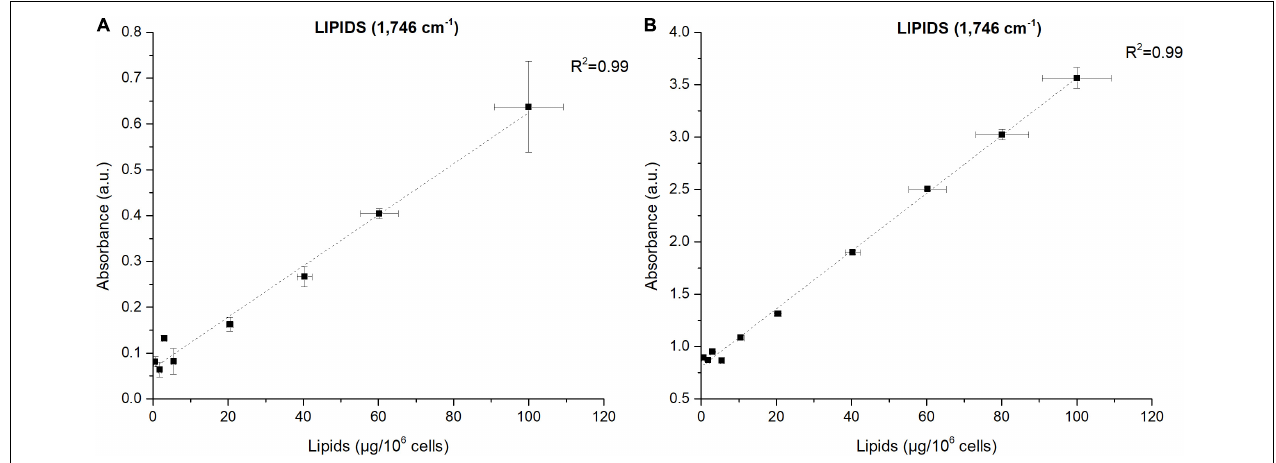
FIGURE 3 | Correlations between FTIR absorbance measured at 1,746 cm – 1 and lipids concentrations quantified by fluorescence after Nile-Red staining considering (A) baseline-corrected spectra and (B) baseline-corrected and normalized spectra. Two million cells were deposited on the silica plate. Coefficients of determination (R 2 ) of the linear regression curves are indicated.